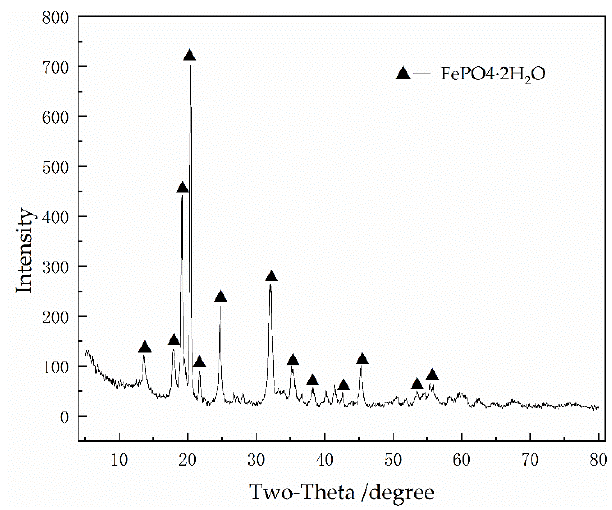
Figure 4. The XRD patterns of the ore after leaching.